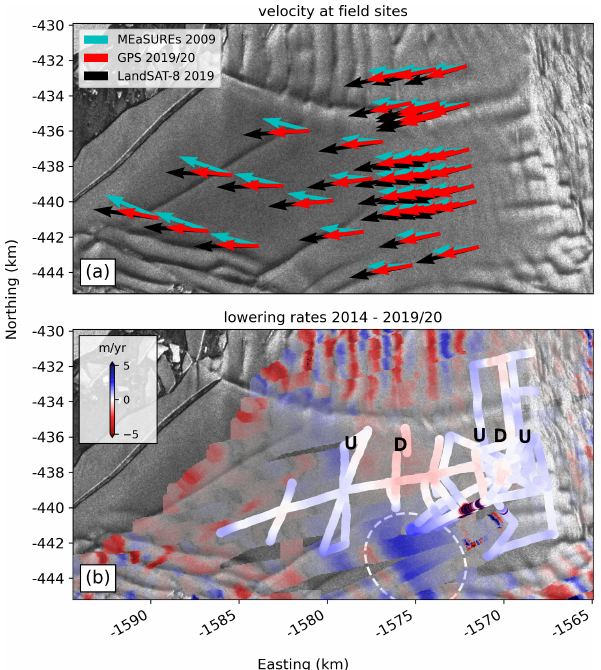
Figure 6. Validation of remote-sensing observations with static and kinematic GPS measurements on the Eastern Ice Shelf overlain on a Sentinel 1 SAR image from October 2019: (a) Counterclockwise rotation of ice flow between 2009 from MEaSUREs to 2019 from Landsat-8 feature tracking in comparison with results from a recent GPS repeat survey. The black Landsat-8 vectors have been length- ened by 33% to increase visibility under the red GPS vectors and are in excellent agreement with the measurements. (b) Comparison between recent Lagrangian rates of surface lowering from a kine- matic GPS survey to validate Lagrangian surface-lowering rates de- rived from ICESat-2 data. Positive values indicate thickening, while negative-value areas delineate vertical thinning. White colors were coded transparent in the ICESat-2 data to highlight the GPS tracks. Tracks were plotted at their migrated locations in 2014. The letters U and D indicate areas of local hydrostatic imbalance, where the ice surface is going up and down, respectively. The dashed white oval shows the location of a spurious thickening signal that we interpret as an artifact from feathering between individual REMA